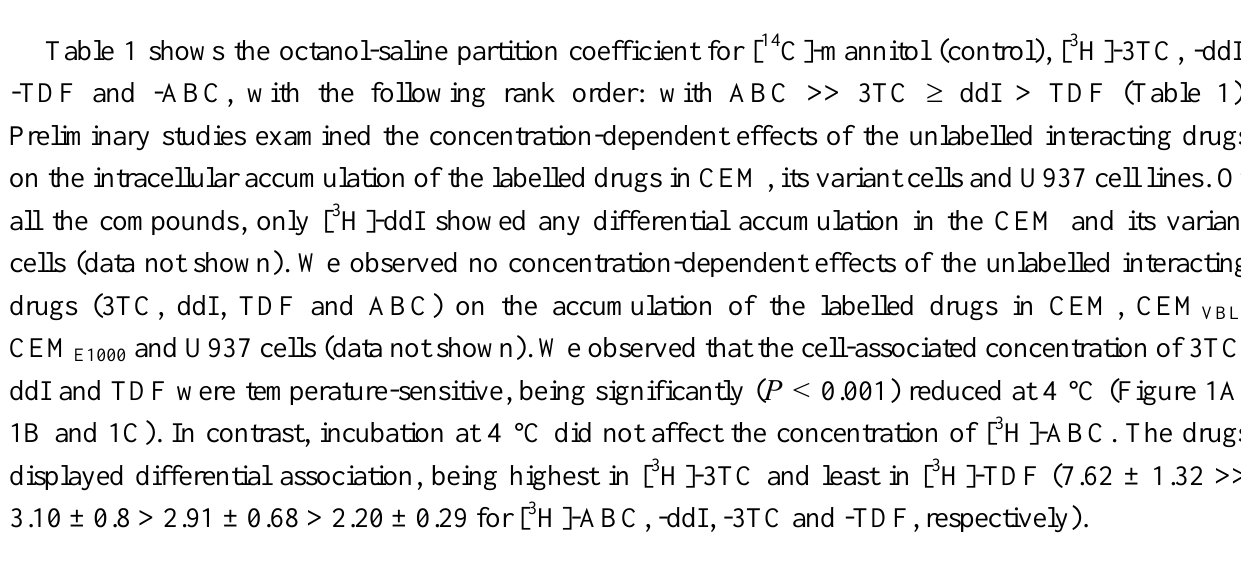
Table 1. Octanol-saline partition coefficients of the